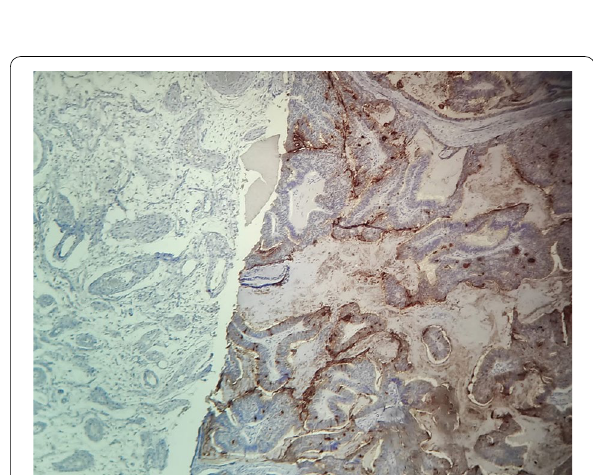
Fig. 5 ACE positive staining in tumor